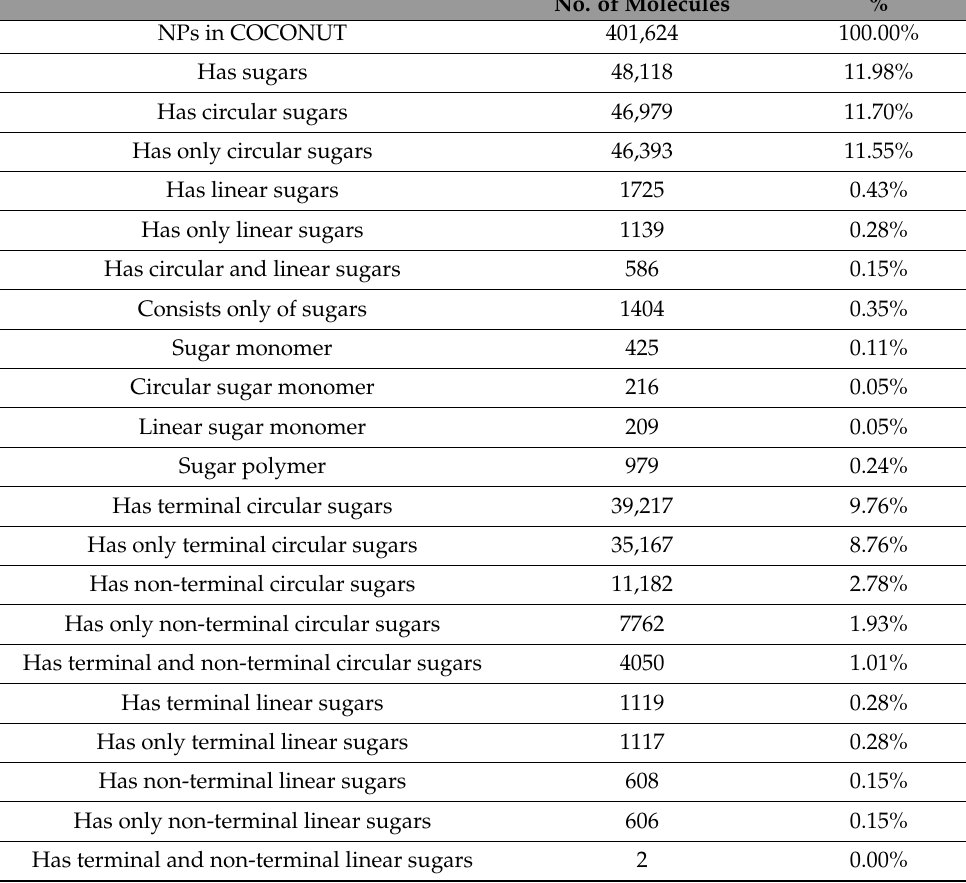
Table 1. Proportions and numbers of the different detected types of glycosidic NPs in